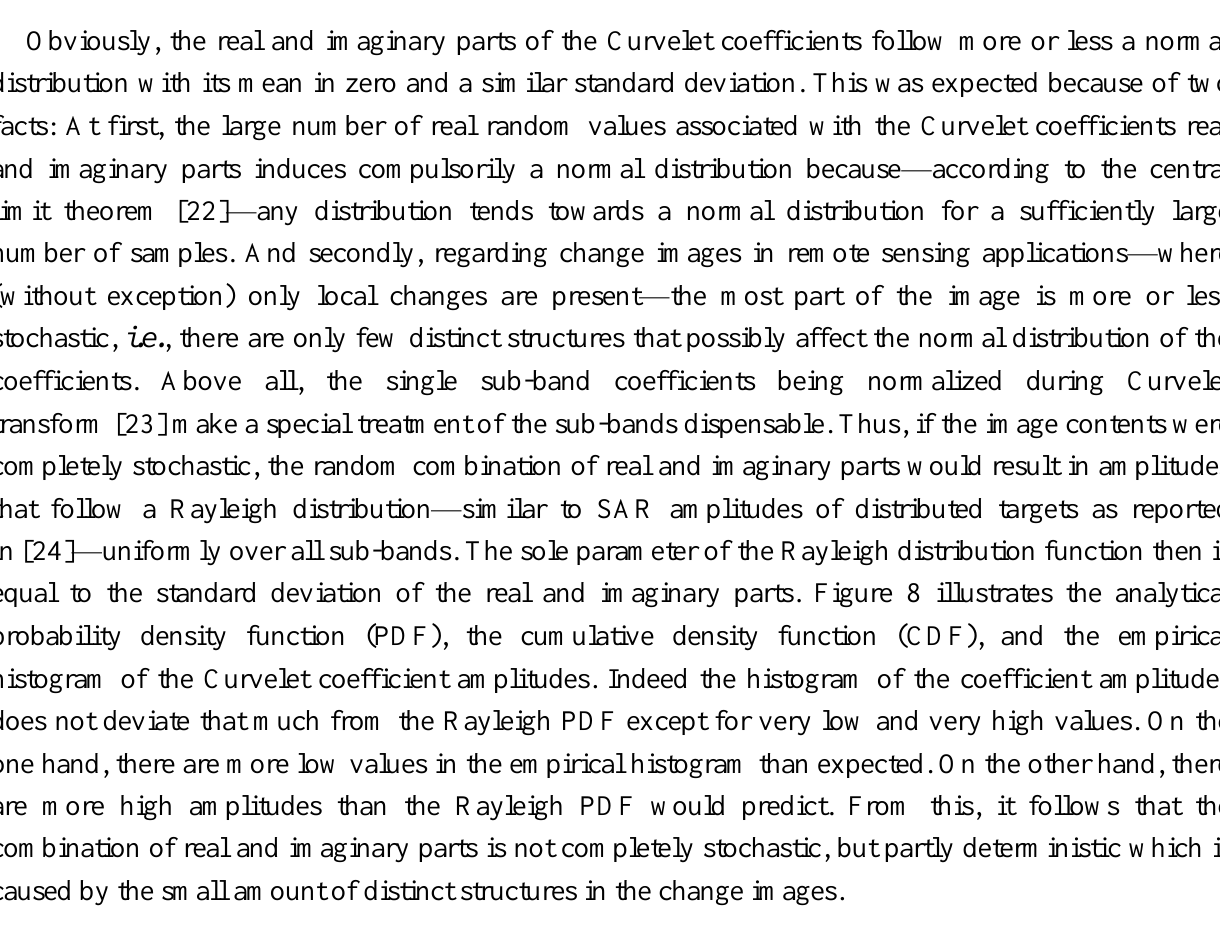
Figure 6. Histogram of the real parts and normal probability density